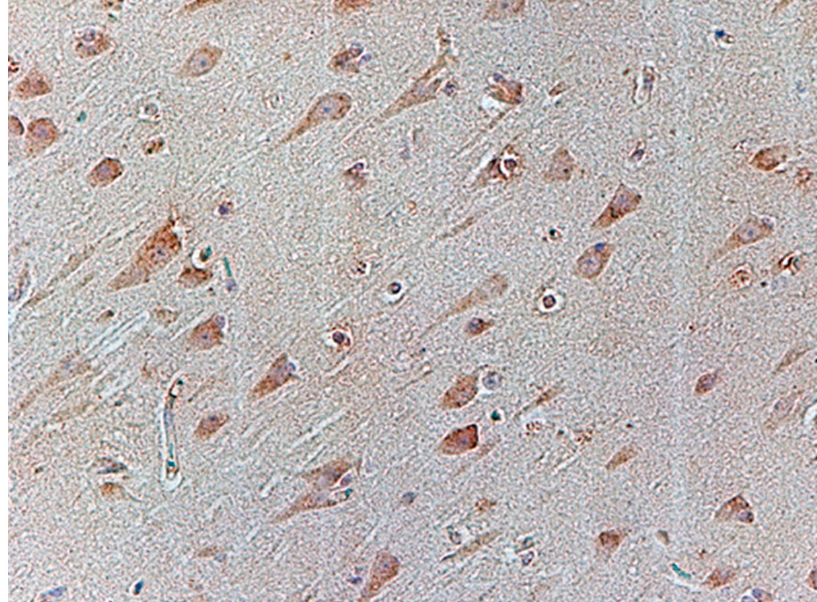
Figure 8. Case no. 3 Frontal lobe of the cortex. Visibly positive immunohistochemical reaction with GLAST in neuronal origin. We did not observe any neuropathological changes in the glutamate transporter in neurons. Magnification 200 × . Table 3. Histological and immunohistochemical findings. (+) immunohistochemical reaction present, ( − ) no immunohisto- chemical reaction, ( × ) no immunohistochemical staining performed. No.